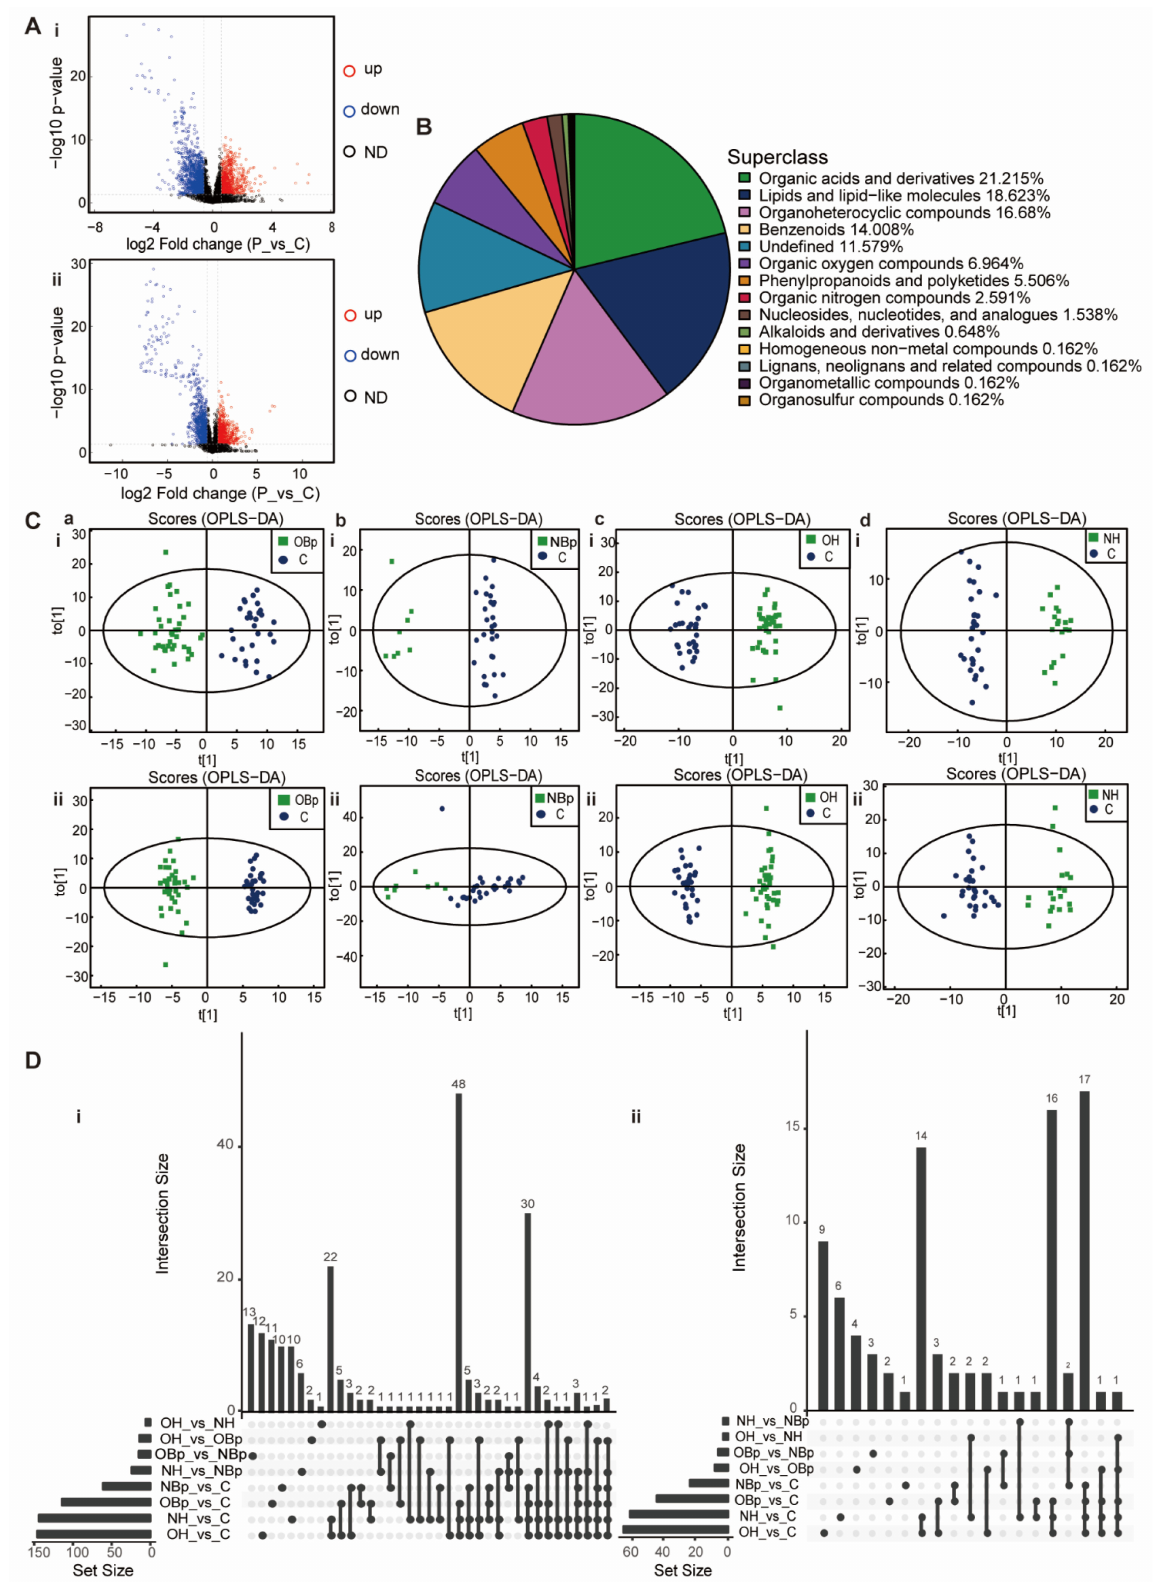
Figure 1. Principal component analysis of the metabolites. ( A ) Volcanic maps of positive ion mode (i) and negative ion mode (ii). Red dots on behalf of up-regulated metabolites satisfying FC >